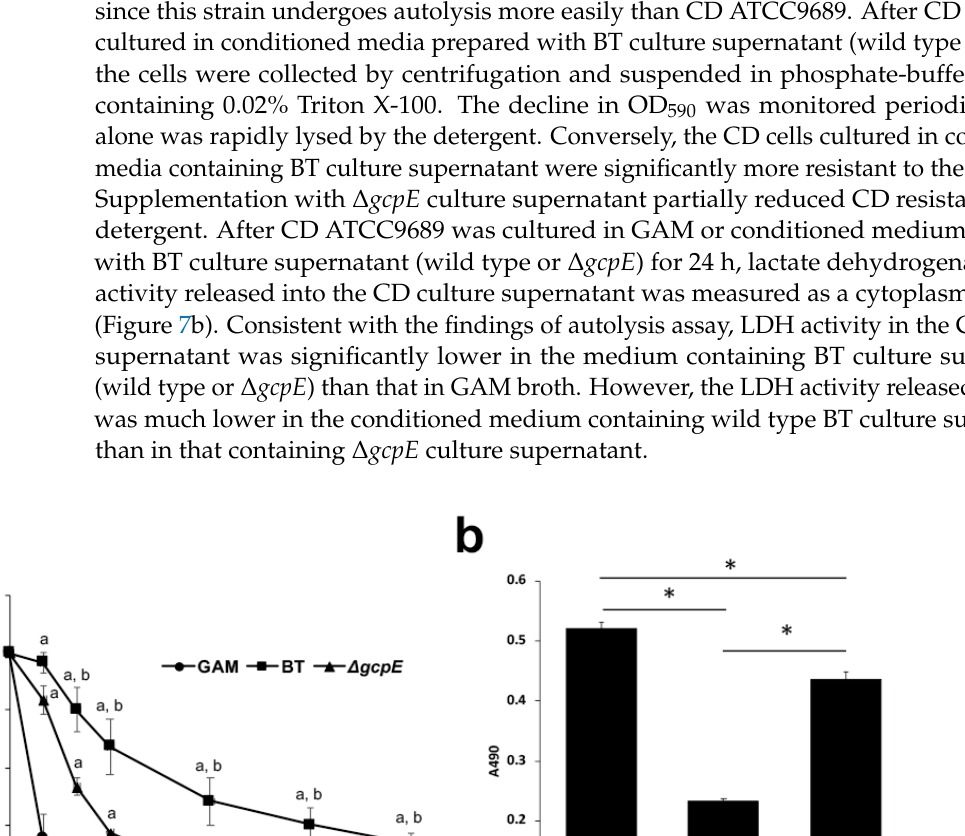
Figure 6. Localization of Toxin A in CD culture. After CD was cultured in the conditioned me- dium containing PF (2.0 mg/mL) derived from GAM broth or BT, the culture was separated into the supernatant and cell pellet by centrifugation. Toxin A levels in the supernatant (S) and cell pellet (P) were evaluated by Western blotting with anti-Toxin A antibody. M, HRP-labeled protein size marker.